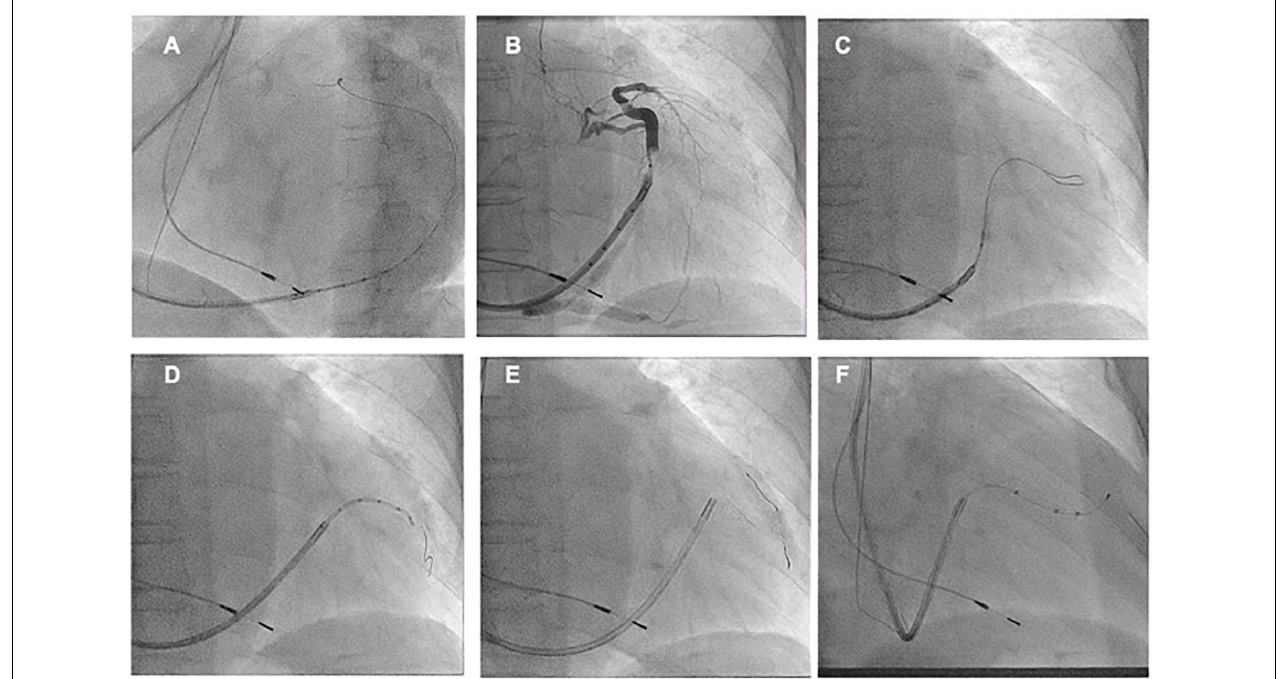
FIGURE 5 | (A) After the right axillary venous puncture, the CS cannulation catheter (CPS Direct TM PL Peelable Outer Guide Catheter ST-JUDE) was guided through the Lee’s venogram balloon catheter to the CS ostium, and then the CS was cannulated in the left anterior oblique position by passing the Radifocus guidewire through the Lee’s venogram balloon. (B) Upon cannulation of the CS, the CS sheath is advanced over the Lee’s venogram balloon into the CS. Then, a coronary venous angiogram is obtained with contrast injection to delineate the venous anatomy and select the target vein (arrow). (C,D) After the Radifocus guidewire was